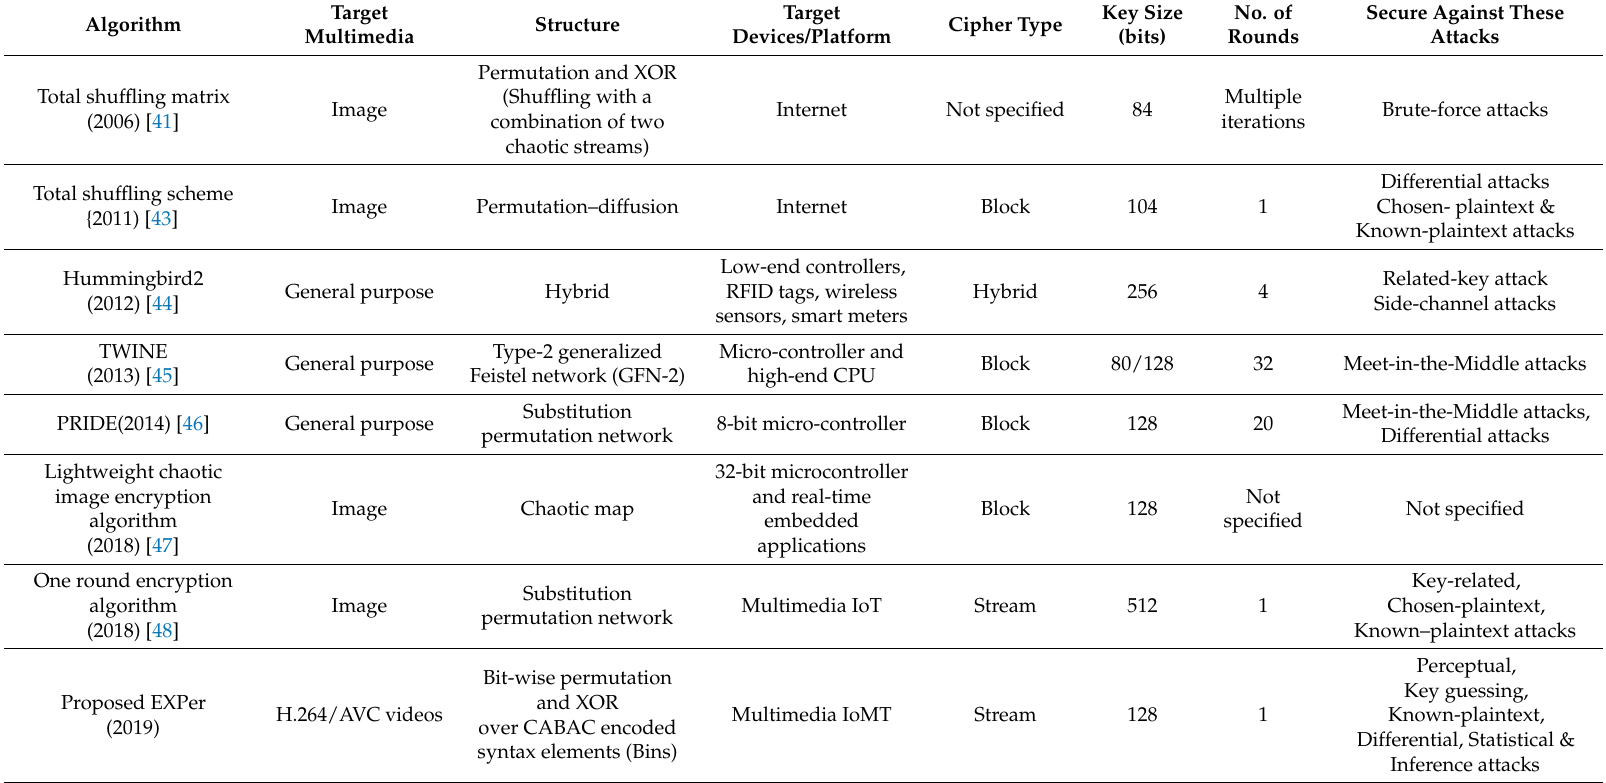
Table 2. Comparative overview of existing lightweight ciphers for constrained devices and Extended Permutation with eXclusive OR